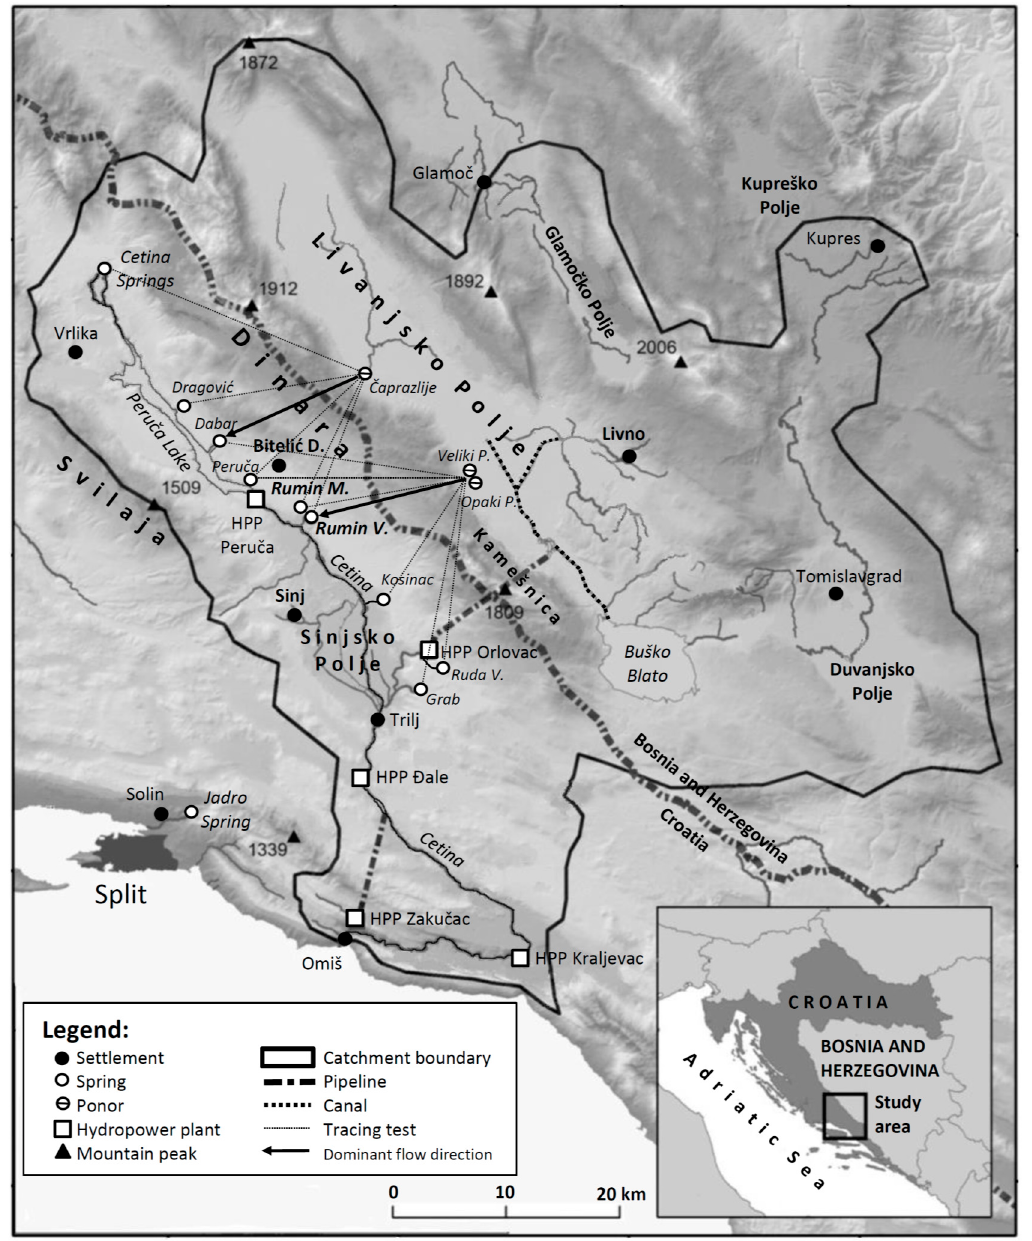
Figure 1. Location map of the Cetina River catchment with groundwater connections determined by tracing tests.